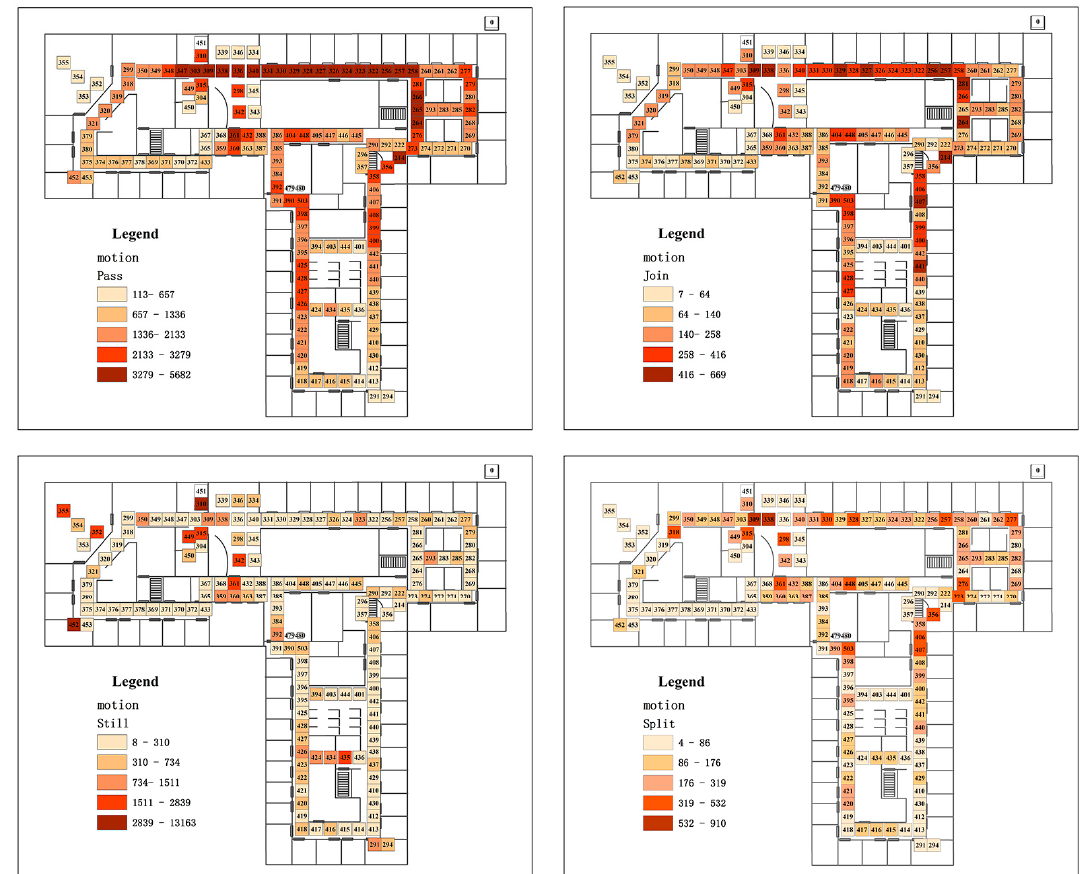
Figure 10. The statistics of the different behaviors.